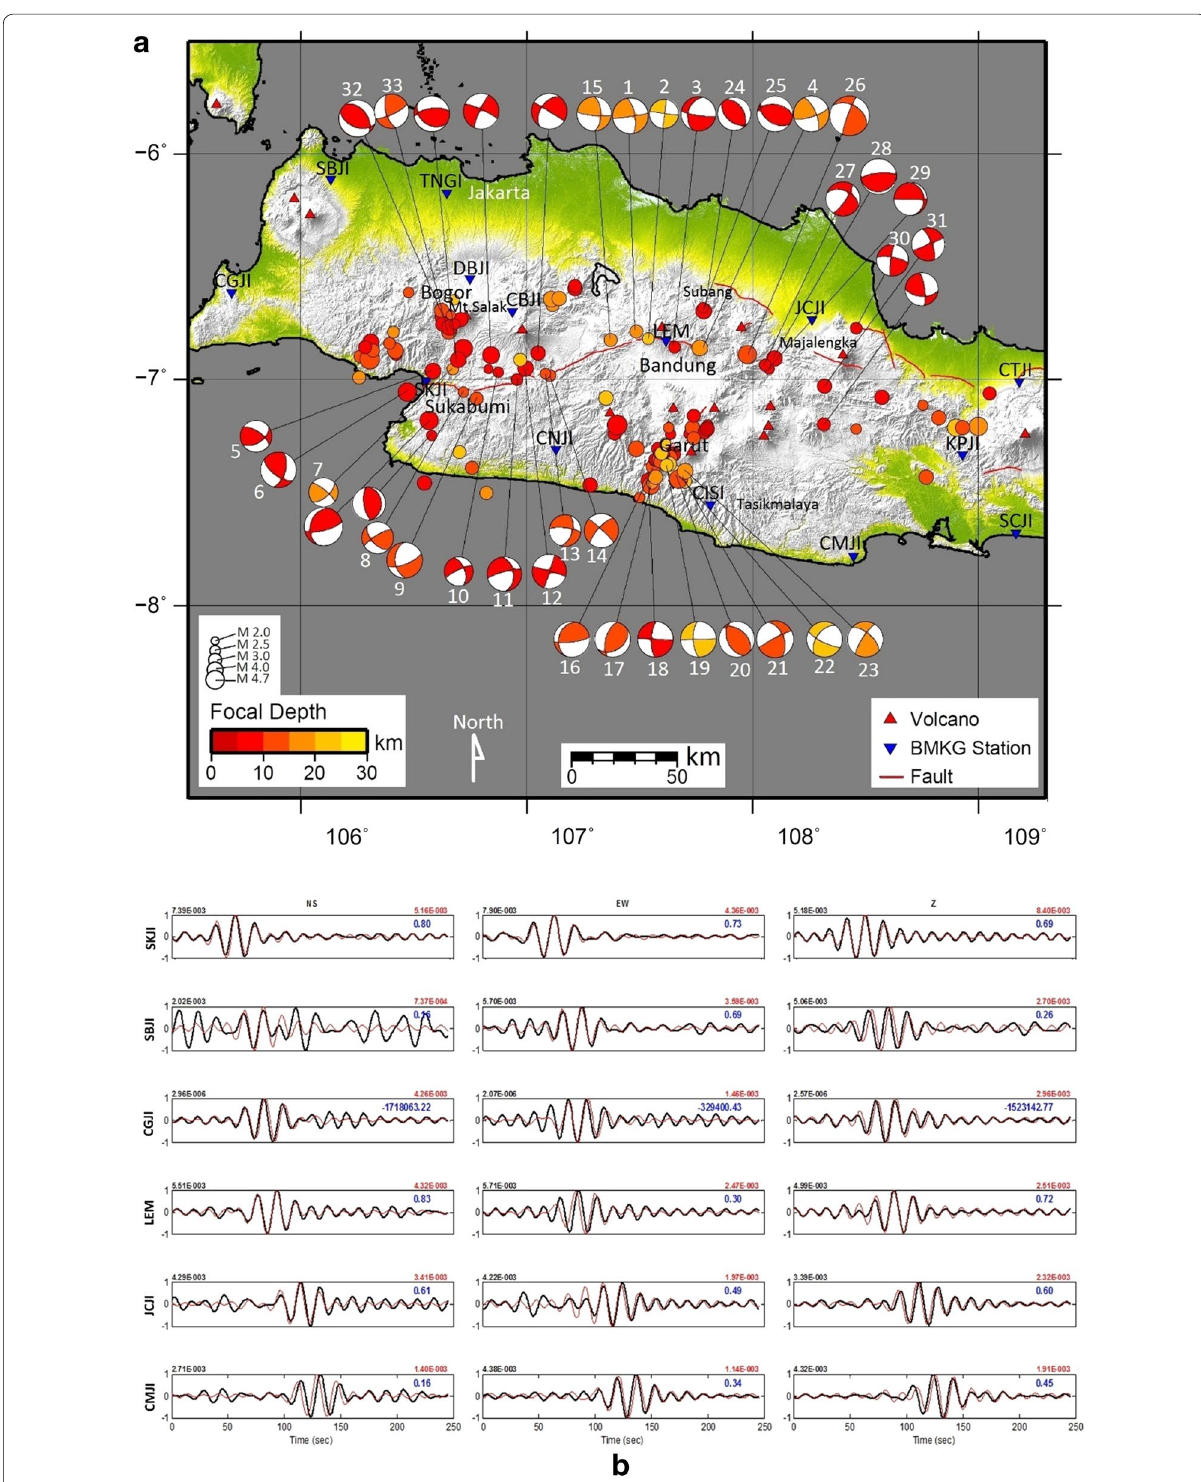
Fig. 6 a Selected focal mechanism solutions of the earthquakes in West Java. b Example of three-component waveform inversions at stations SKJI, SBJI, CGJI, LEM, JCJI, and CMJI of the 8 September 2012 event (number 32 in a ). Red and black waveforms are synthetic and observed waveforms,